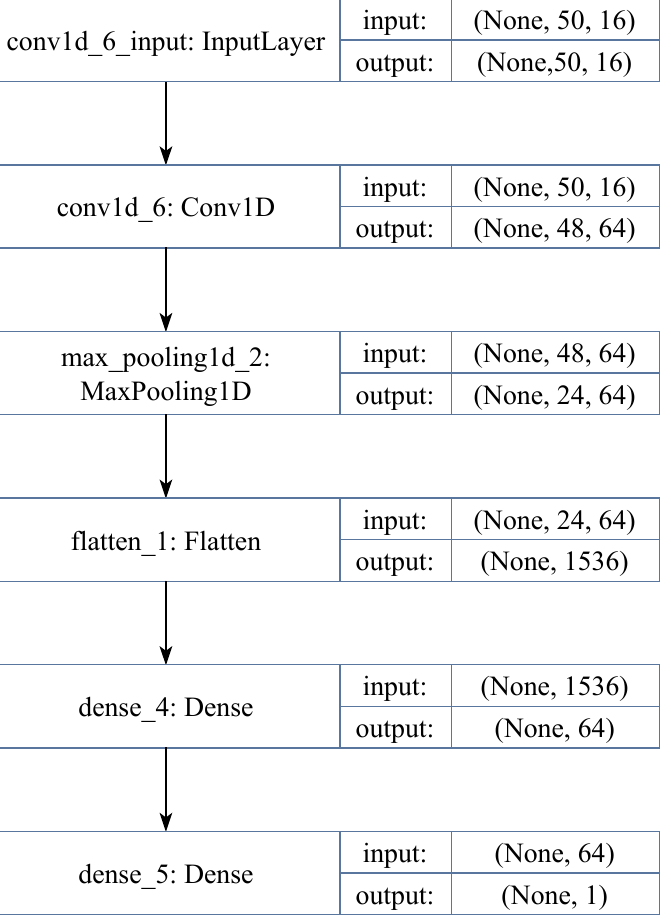
Figure 15. Proposed CNN architecture for RUL forecasting (adapted from